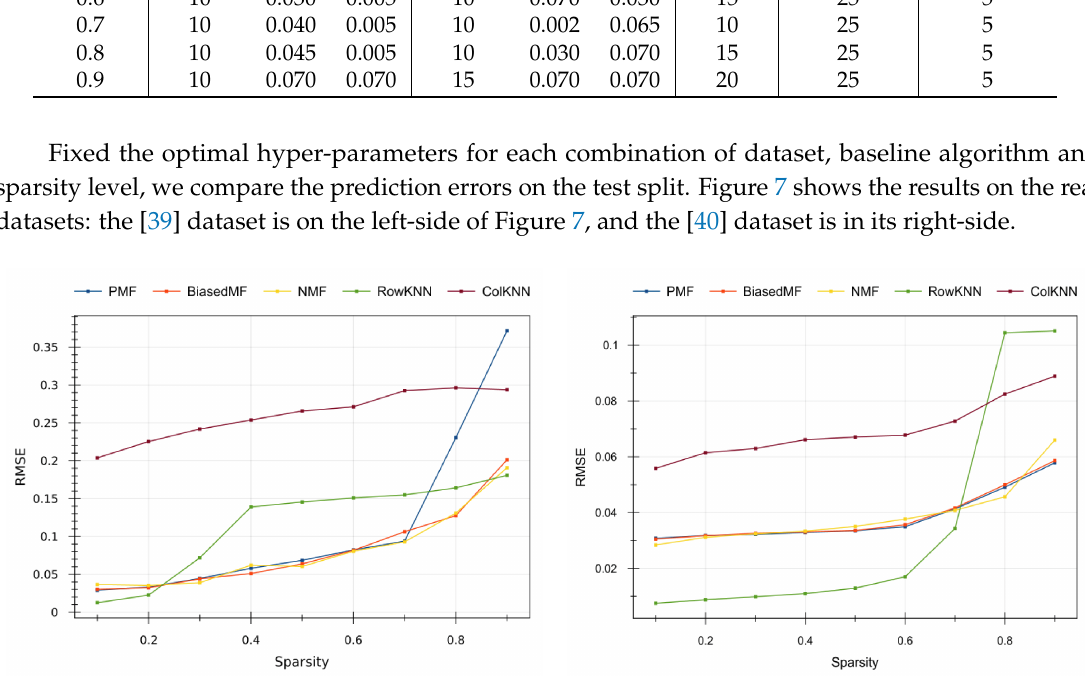
Figure 7. Prediction quality results. Left side: [39] dataset, right side: [40] dataset; x -axis: sparsity levels; y -axis: prediction error. Best results are the closest to zero (low